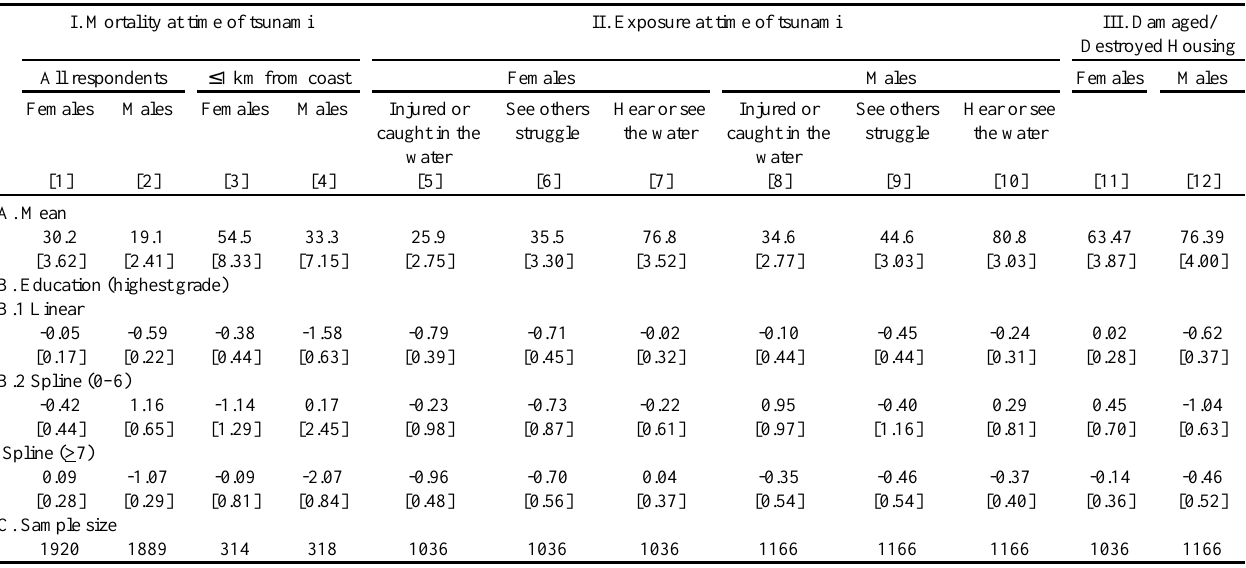
Table 2. Mortality and exposure at time of the tsunami I. Mortality at time of